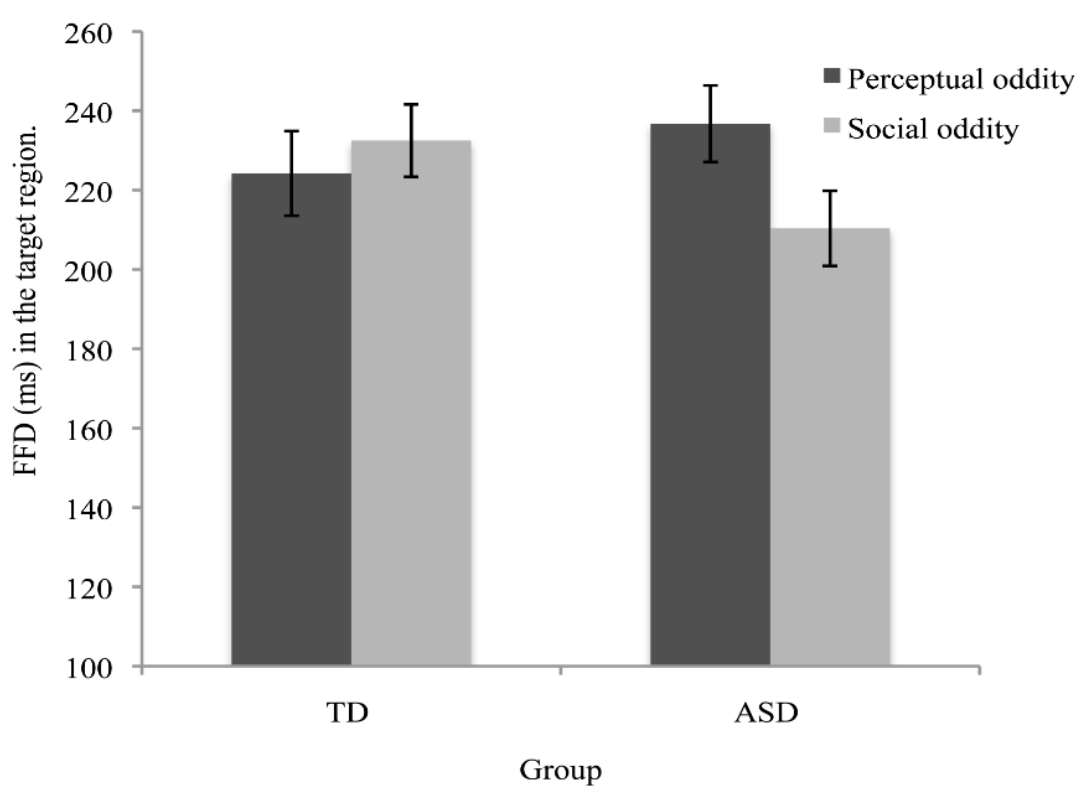
Figure 5. The interaction between oddity type and group for first fixation duration (FFD) detected in Benson et al.’s [61] experiment, indicating a temporal delay in the initial detection of social, but not physical / perceptual, oddities for autistic adults. Reproduced with permission from John Wiley and Sons.